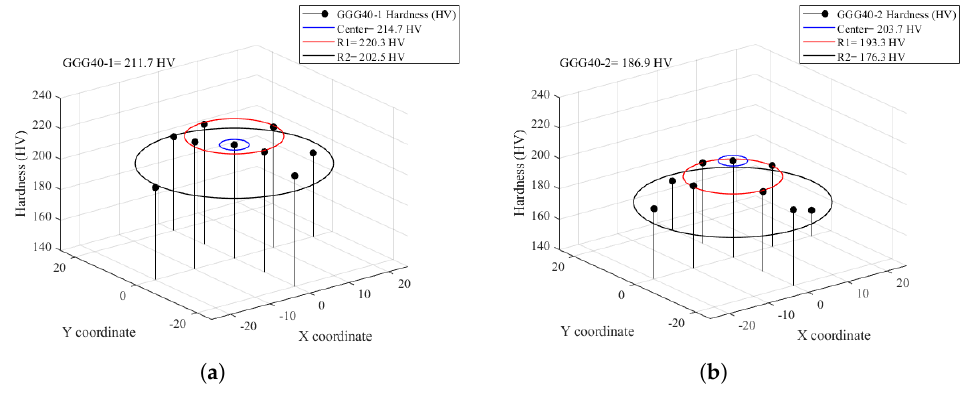
Figure 15. Hardness test round bar sample. ( a ) GGG40-1. ( b )